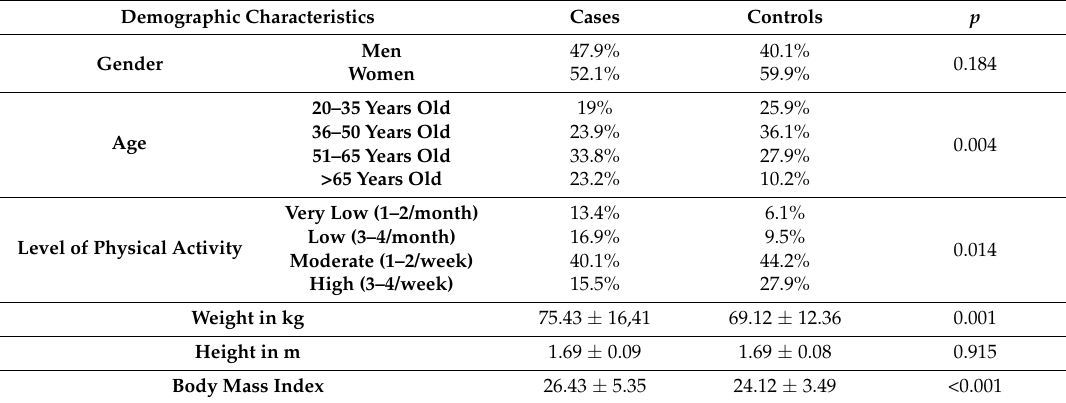
Table 1. Cases–controls comparisons in relation to demographic characteristics. Demographic